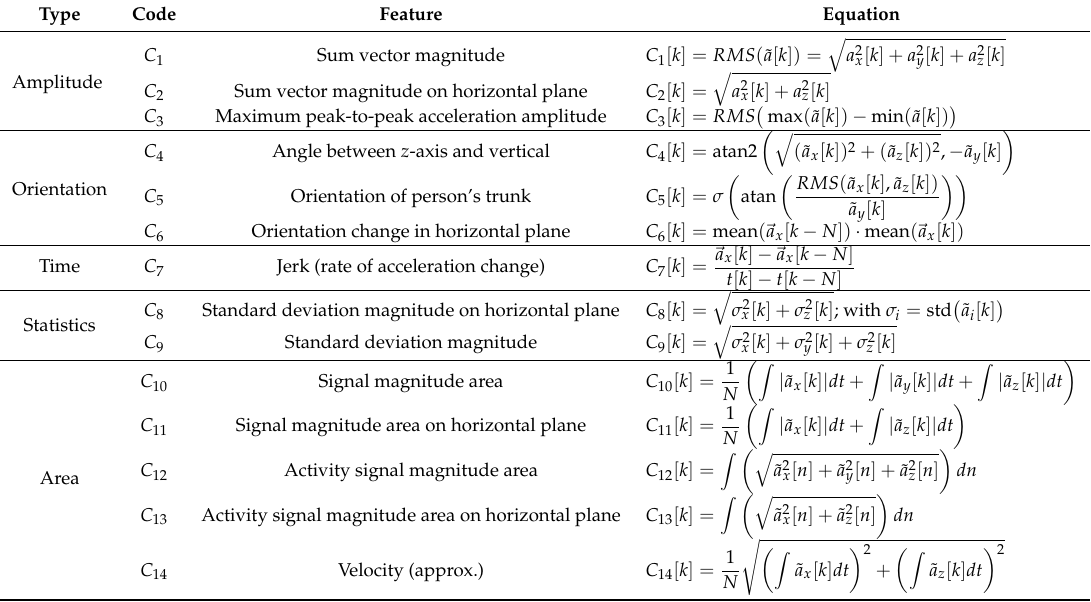
Table 4. Feature extraction characteristics used to test the proposed